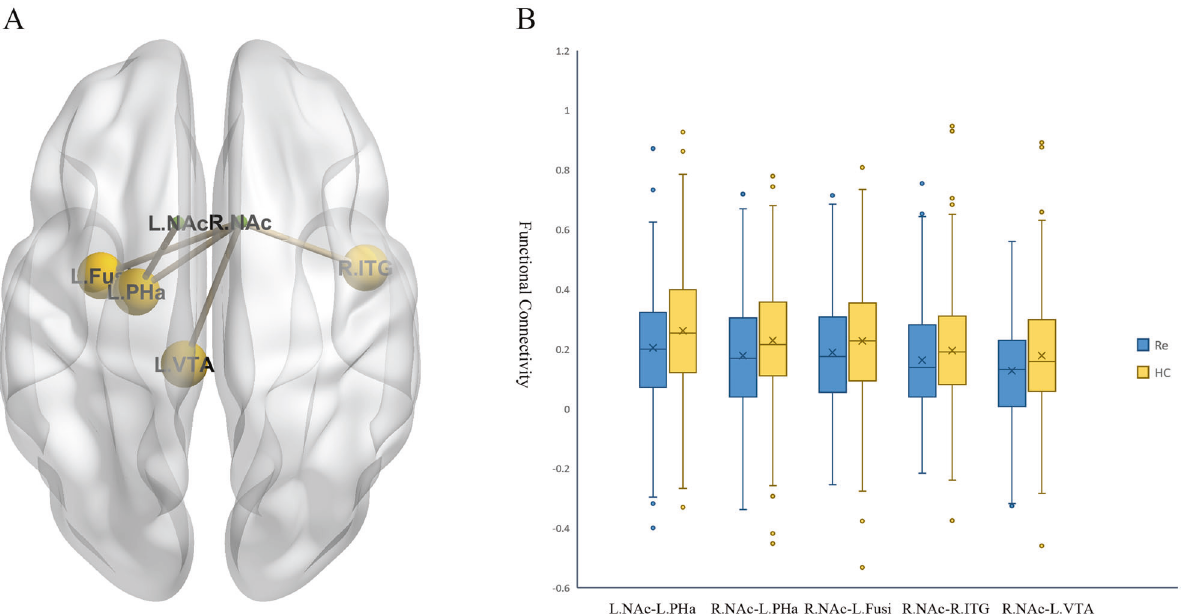
Fig. 2 Results of mega-analysis. A The signi fi cant between-group differences in the NAc functional connectivity. B The box fi gures show the distribution of signi fi cantly disrupted bilateral NAc functional connectivity in the group comparison. Fusi fusiform gyrus, HC healthy control, L left, NAc nucleus accumbens, PHa parahippocampal gyrus, R right, Re recurrent major depressive disorder, ITG inferior temporal gyrus, VTA ventral tegmental area.